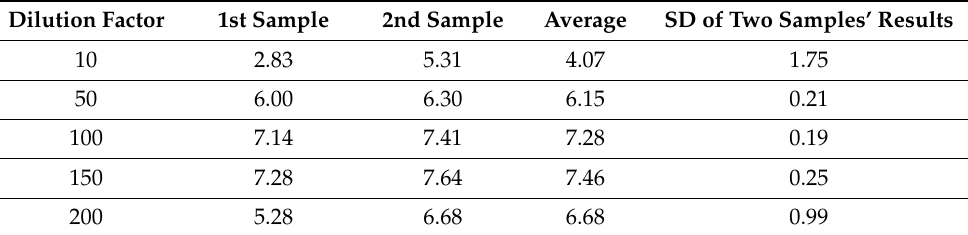
Table 1. The effect of dilution factor on creatinine results with two samples measured for each dilution